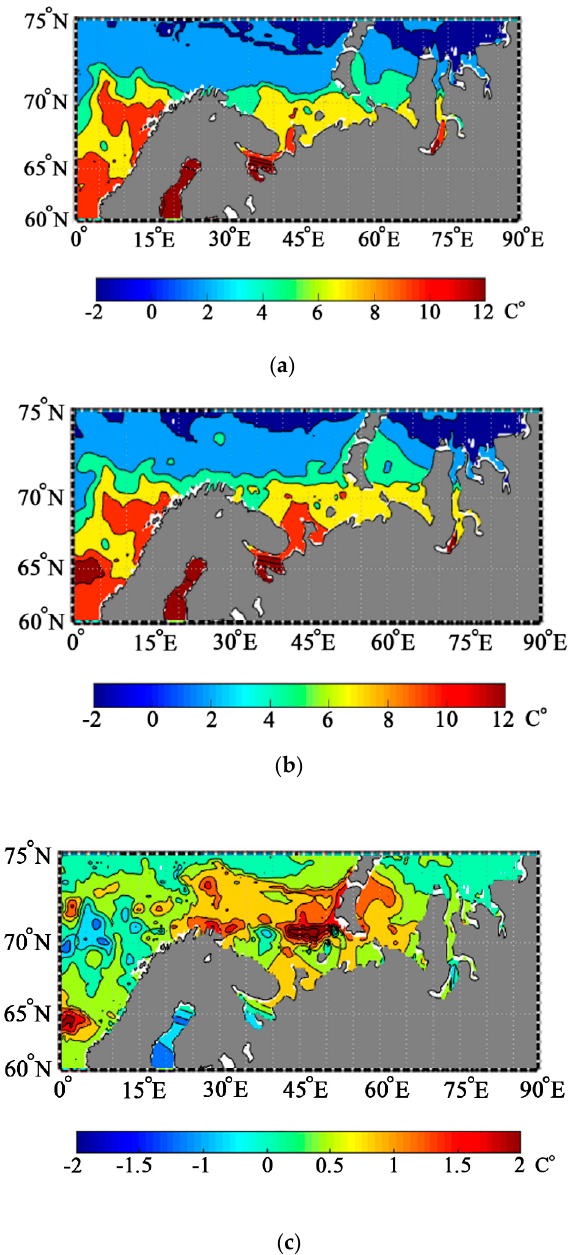
Figure 5. Sea surface temperature on July 15, 2013: ( a ) calculation with no DA; ( b ) calculation with DA; ( c ) difference between sea surface temperatures (SSTs) in the calculations with and without DA.